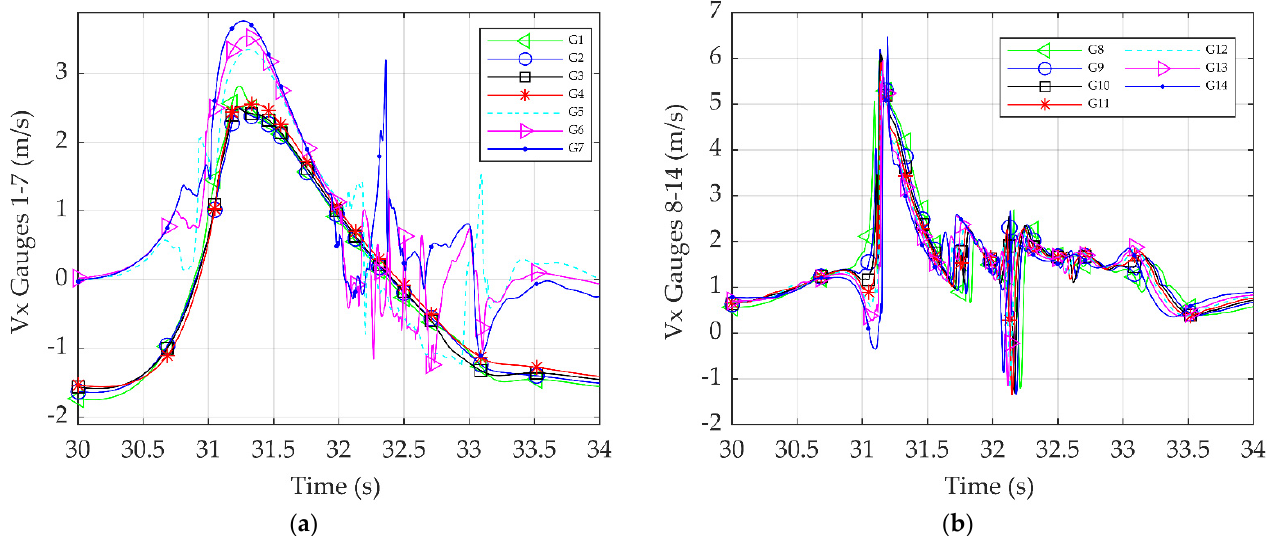
Figure 9. Velocity in the x -direction for all the wave gauges at 90° over time for: ( a ) Gauges 1–7 and ( b ) Gauges 8–14.